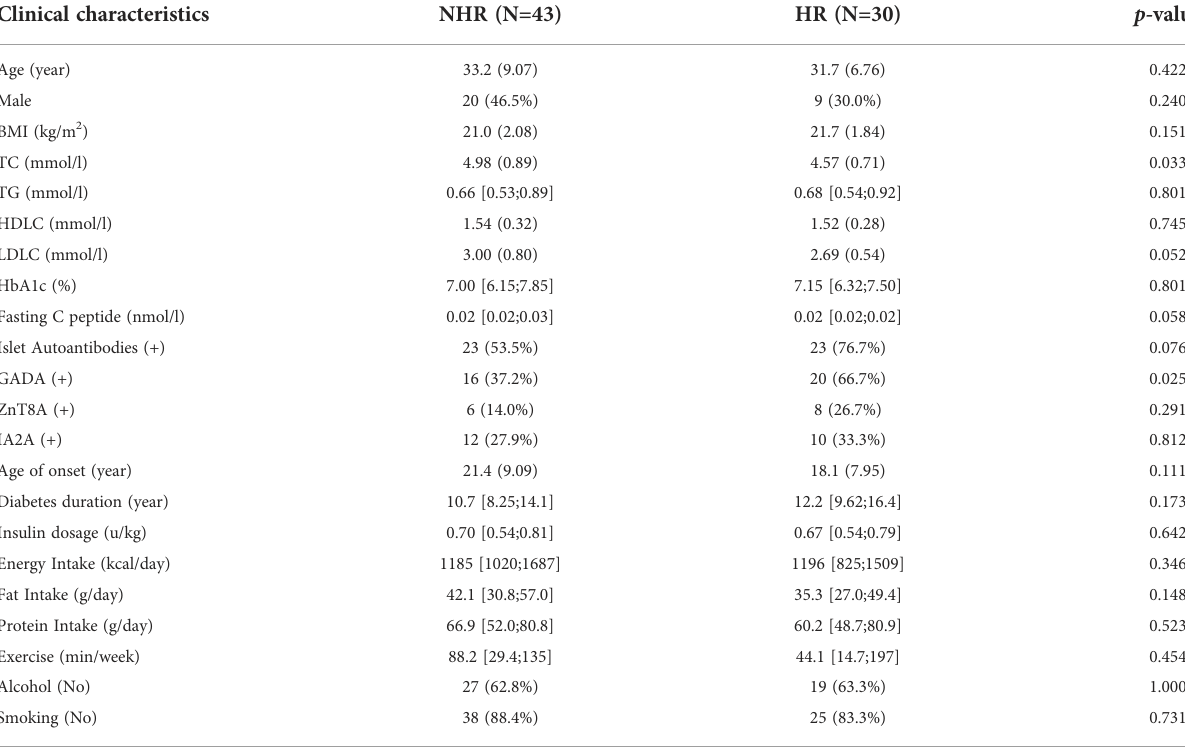
TABLE 1 Clinical characteristics of the T1D patients. Clinical